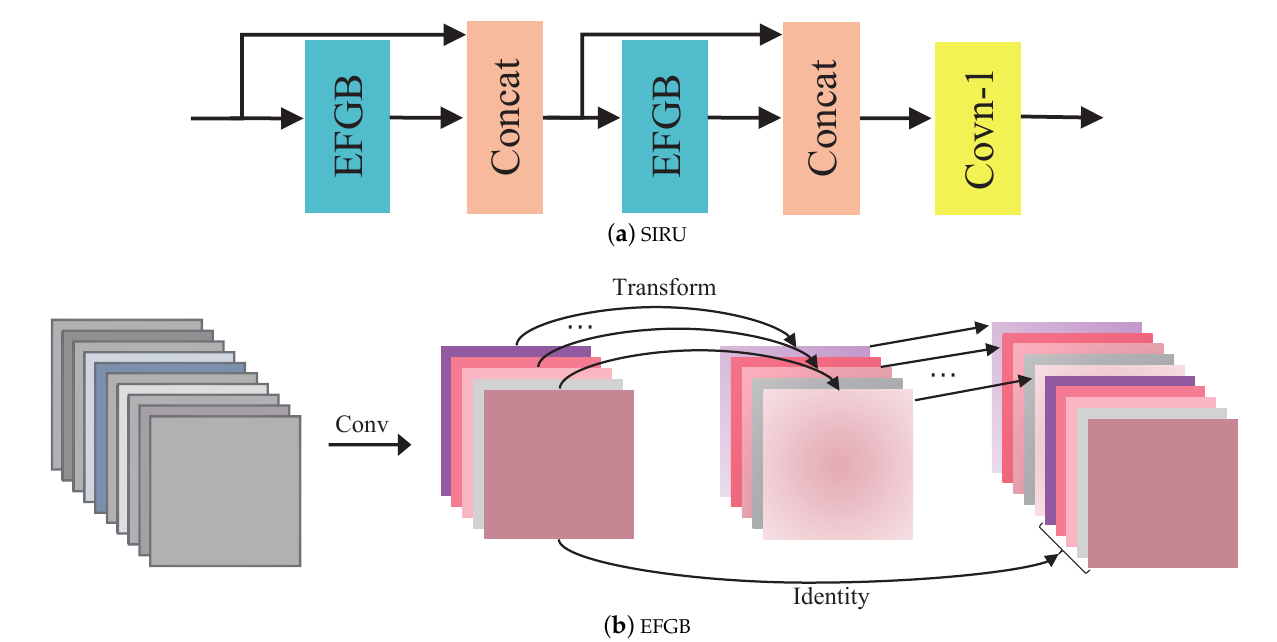
Figure 3. ( a ) The architecture of SIRU. ( b ) An illustration of efficient feature generating